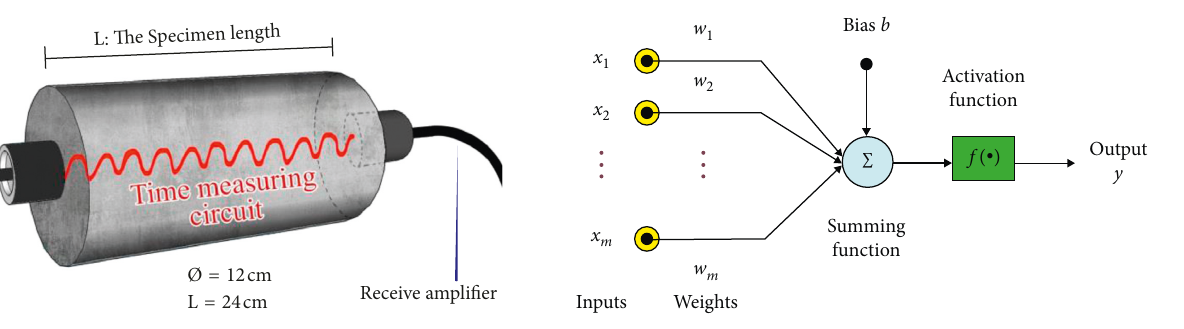
Figure 6: Model of network block [32].